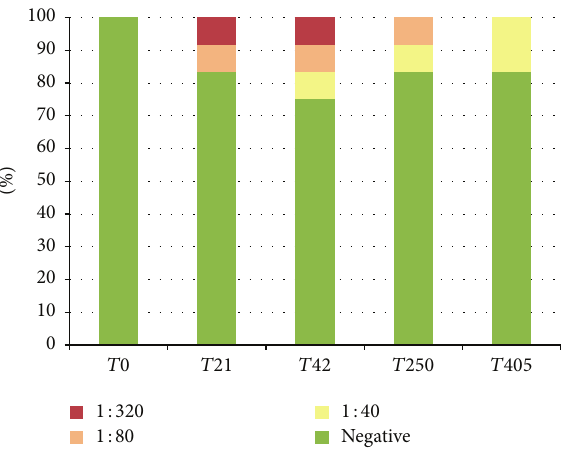
Figure 2: IFAT positivity (%), Group